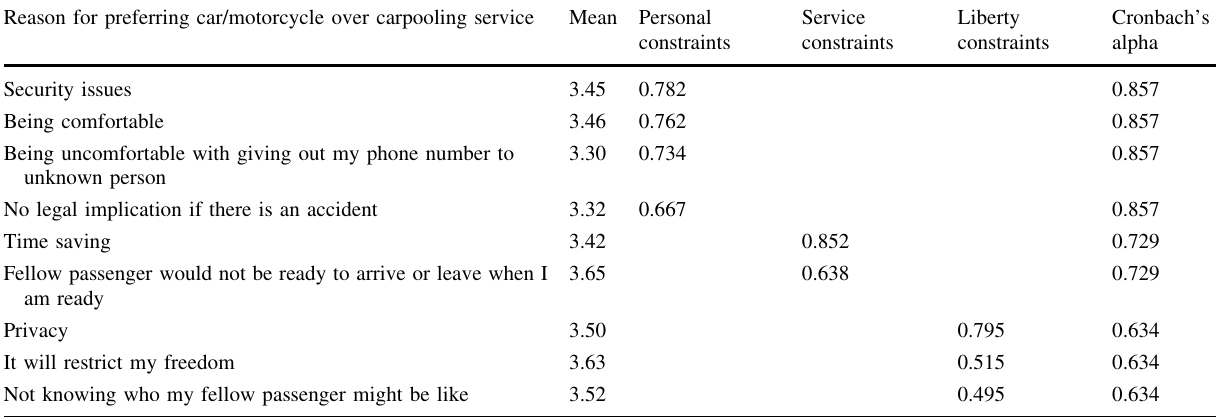
Table 4 Rotated factor loadings for preferring private vehicle over carpooling Reason for preferring car/motorcycle over carpooling